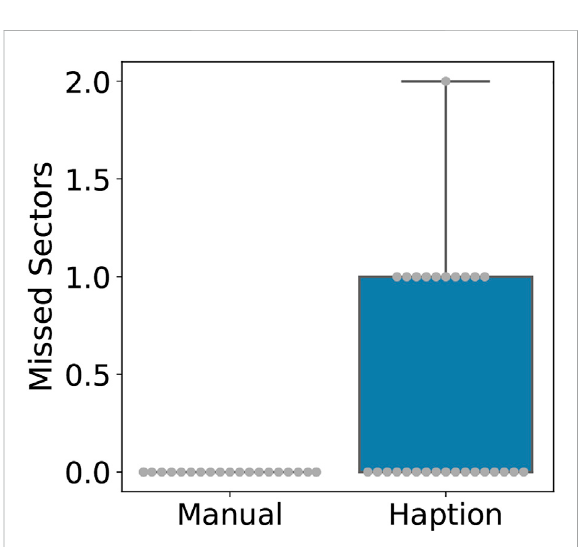
FIGURE 7 Boxplot with overlaid beeswarm plot comparing the number of contaminated tiles not reported per